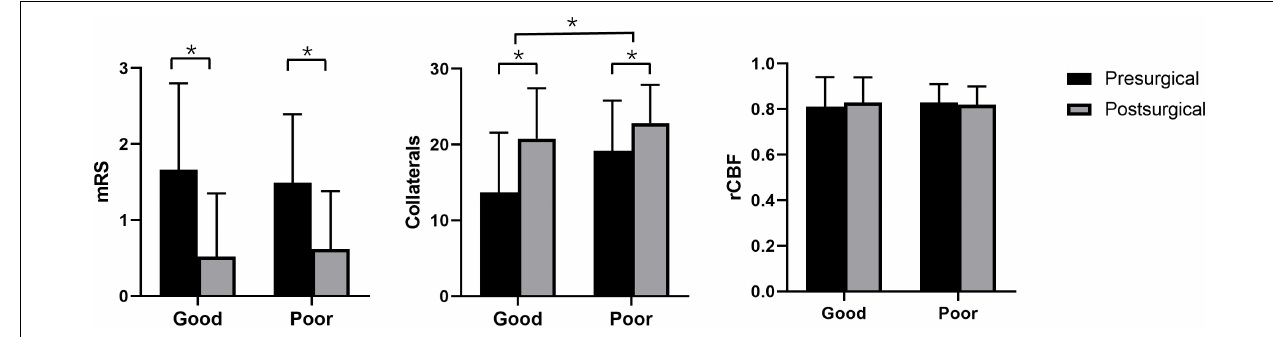
FIGURE 1 | Pre- and postsurgical modified Rankin Scale, collateral perfusion, and relative cerebral blood flow based on arterial spin labeling between good and poor surgical collaterals. * p < 0.05 between two groups. TABLE 2 | Univariable and multivariable logistic regression results. Univariable regression Multivariable regression Model